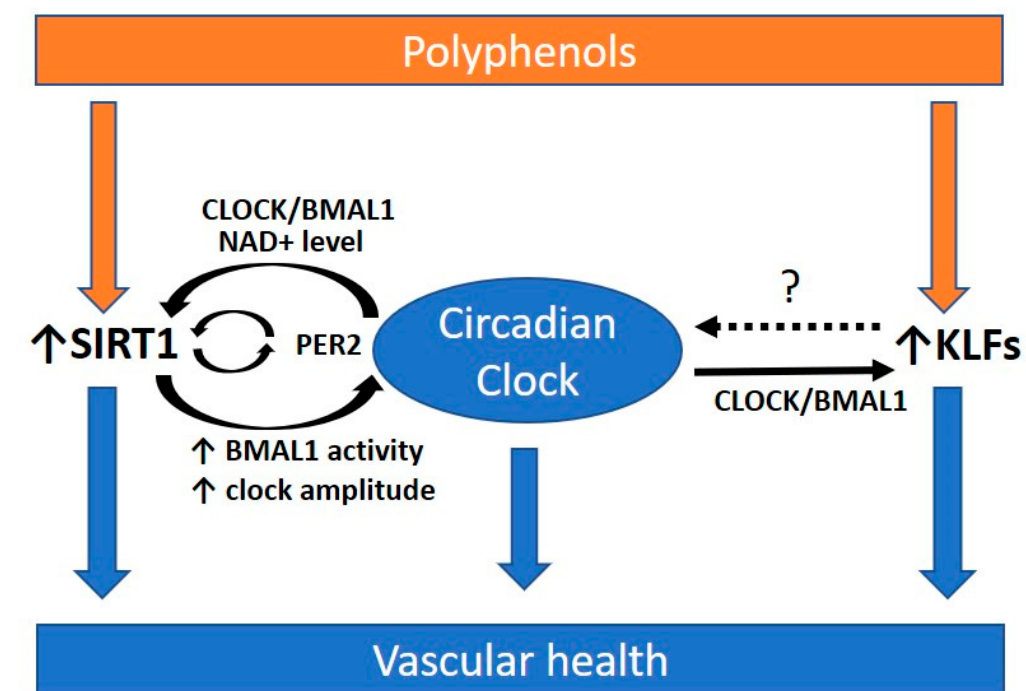
Figure 3. Polyphenols and the circadian rhythm for promoting vascular health. Polyphenols are secondary metabolites of plants, which have been widely studied for their beneficial effects on cardiovascular health. Polyphenols may be beneficial in preventing atherosclerosis via modulating the circadian clock. Polyphenols have been shown to enhance the expression of Krüppel-like factors (KLFs) and Sirtuin 1 (SIRT1), which are highly associated with the circadian clock. SIRT1 and KLFs are important players in protecting against atherosclerosis. SIRT1 interacts with the circadian clock and is required for high-magnitude circadian transcription of circadian clock genes. The circadian clock can regulate SIRT1 activity via the oscillating NAD+ level. The transcription of KLFs is regulated by direct promoter binding of CLOCK:BMAL1. However, whether KLFs have a feedback control to the circadian clock remains unclear (dotted arrow and ?). A functional circadian clock is required for preventing atherosclerosis. PER2, period 2. BMAL1, brain and muscle aryl hydrocarbon receptor nuclear translocator-like protein 1; CLOCK, circadian locomotor output cycles kaput. NAD+, oxidized nicotinamide adenine dinucleotide.